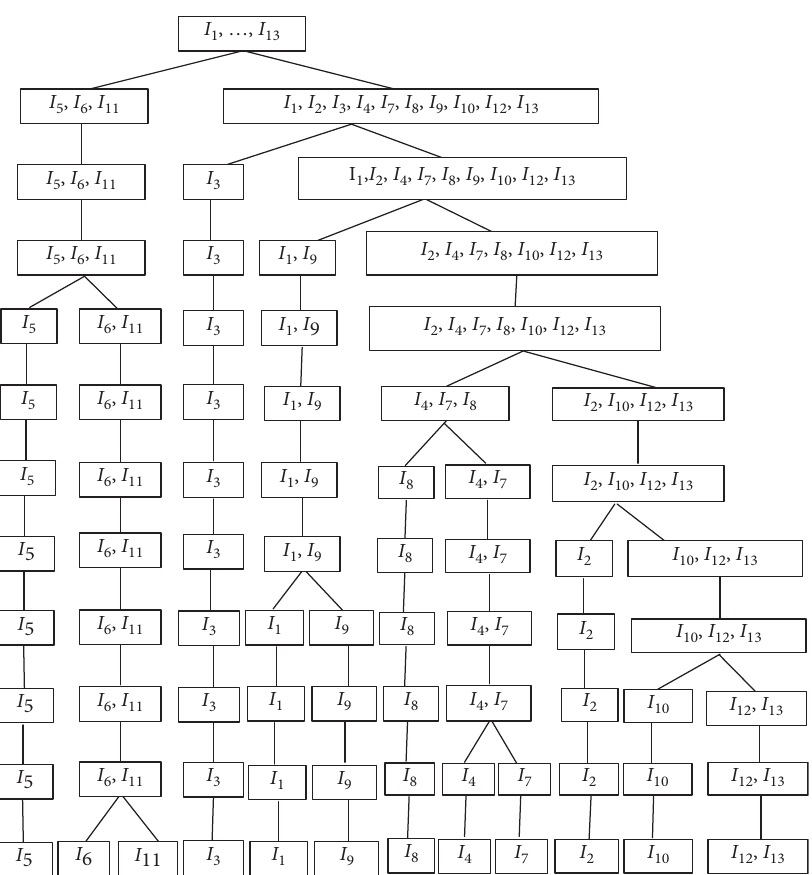
Figure 2: Cluster analysis of average insertion of 19